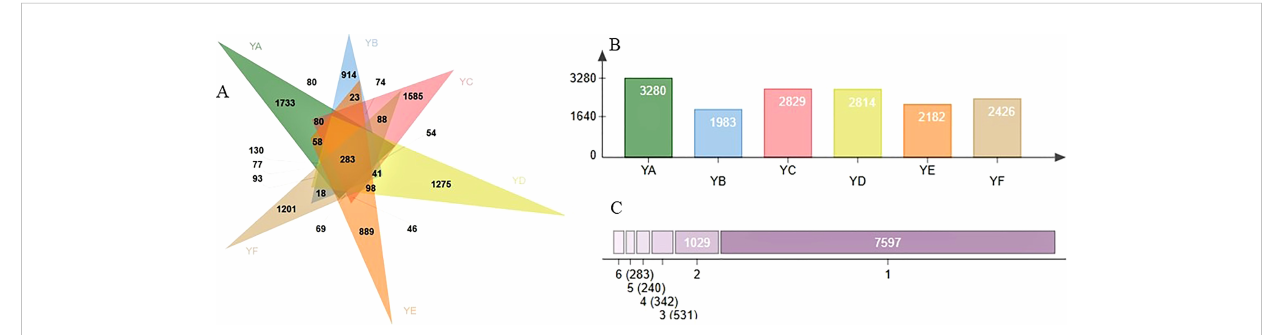
FIGURE 1 (A) venn diagram for different sample leaves; (B) number of ASVs per grouping; (C) number of ASVs, speci fi c (1) or shared by 2,3, ..., 6. YA: Populus × euramaricana ‘ Bofeng 3 hao ’ ; YB: P. deltoides ‘ Shanghaiguan ’ × P. deltides ‘ Harvard ’ ; YC: P. nigra ‘ N46 ’ ; YD: P. nigra ‘ N102 ’ ; YE: P. × euramericana ‘ Guariento ’ ; YF: P. alba × P. glandulosa ‘ 84k ’